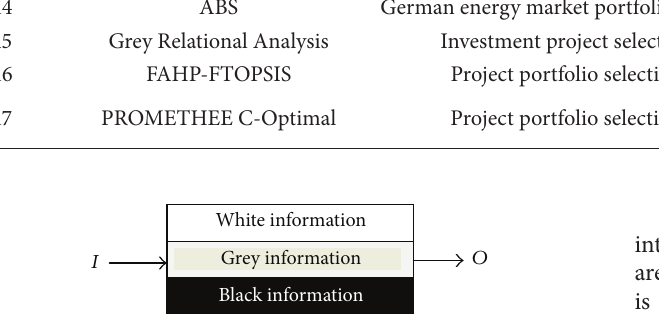
Figure 1: The Idea of a grey